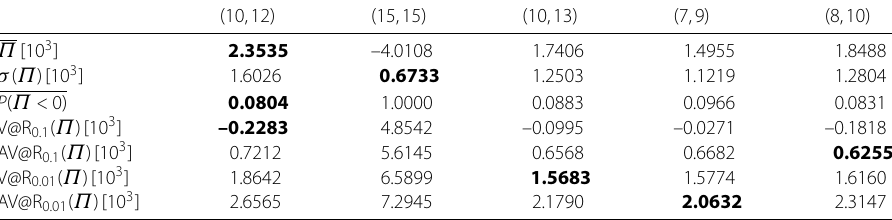
Table 2 Comparison of the different profit evaluations for ( N 1 , N 2 ) (10,12) (15,15) (10,13) (7,9) (8,10) Π [10 3